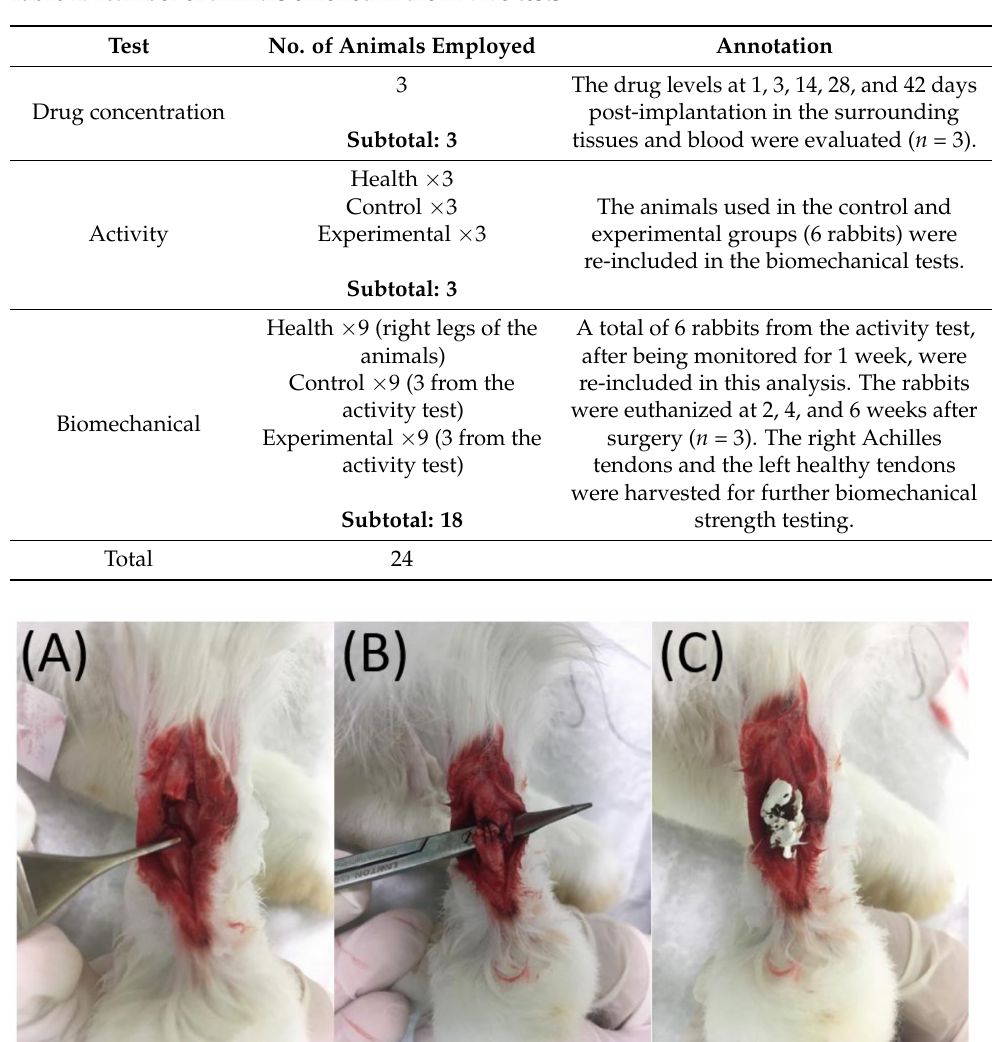
Table 1. Number of animals enrolled in the in vivo tests.